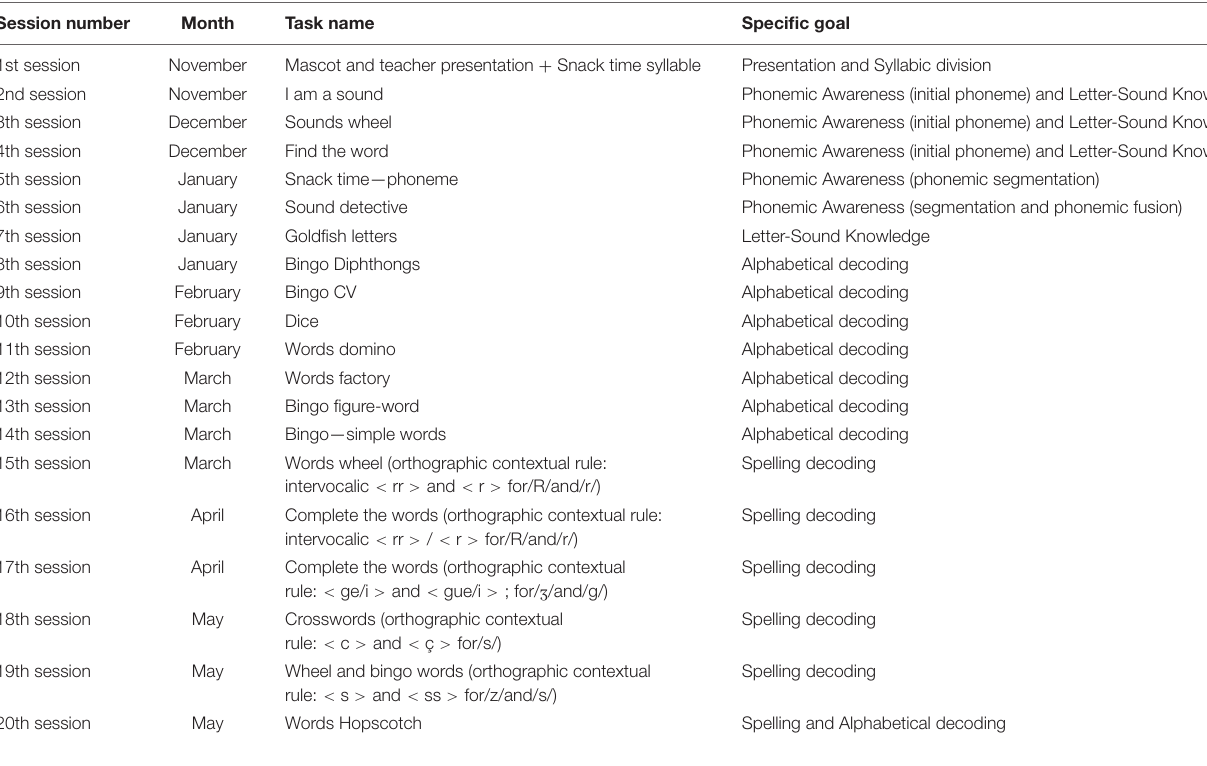
TABLE 1 | PPCL program: chronogram of activities, specifying specific goals. Session